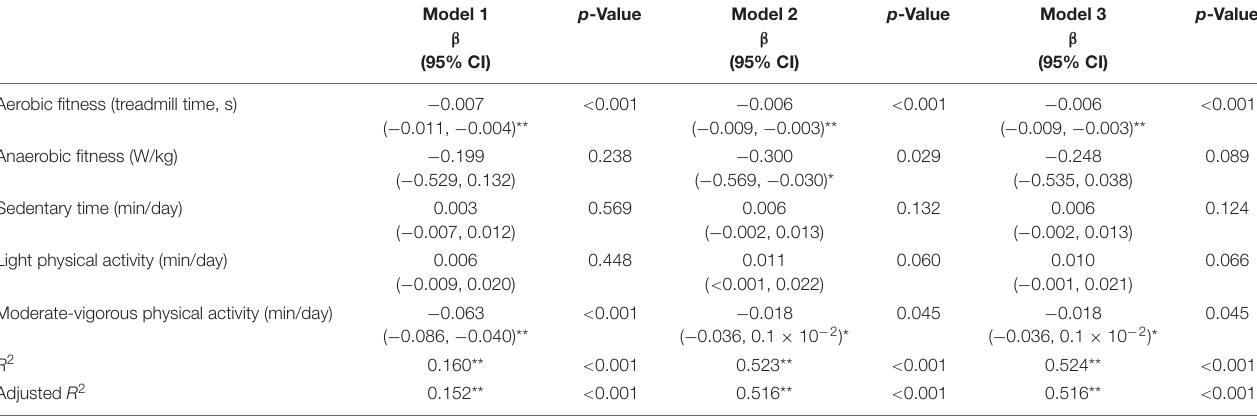
TABLE 3 | Associations between aerobic and anaerobic fitness, physical activity, and body adiposity.